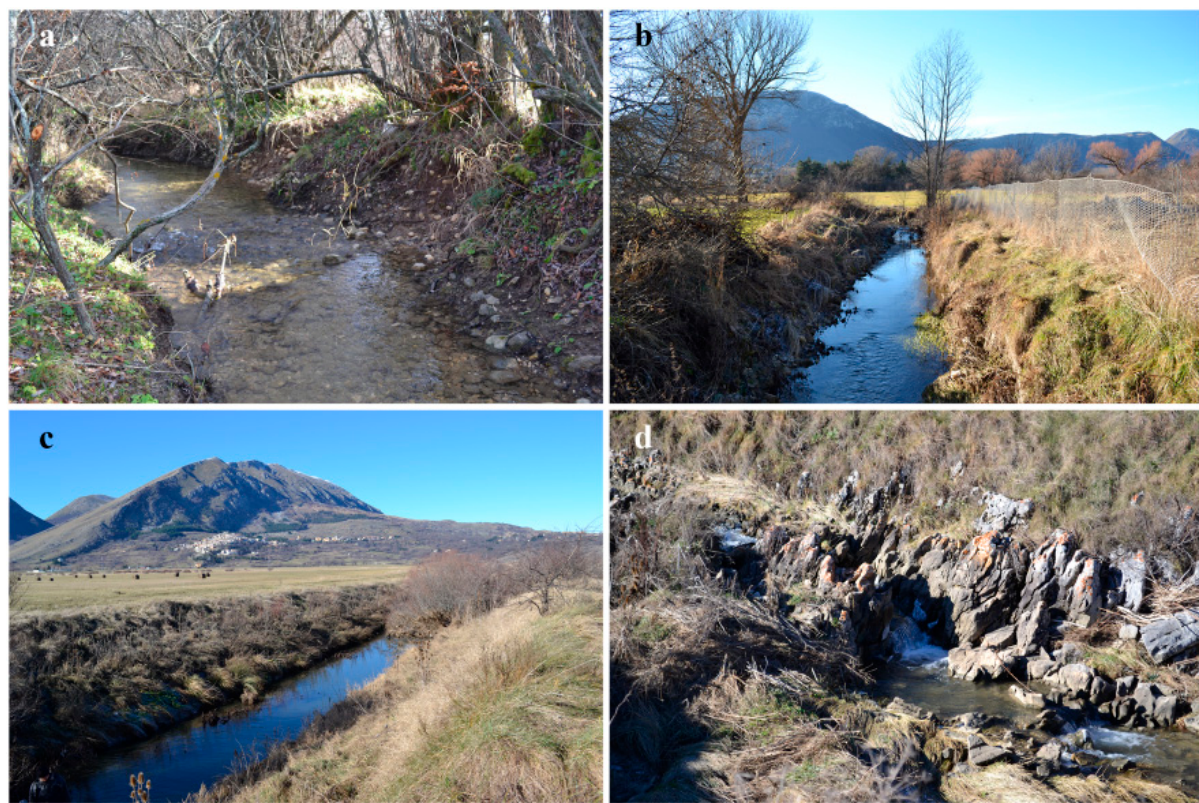
Figure 2. Pictures showing the main features of the sampling sites along the Rio Gamberale stream: ( a ) RG_b2; ( b ) RG_b3; ( c ) RG_b4; ( d )